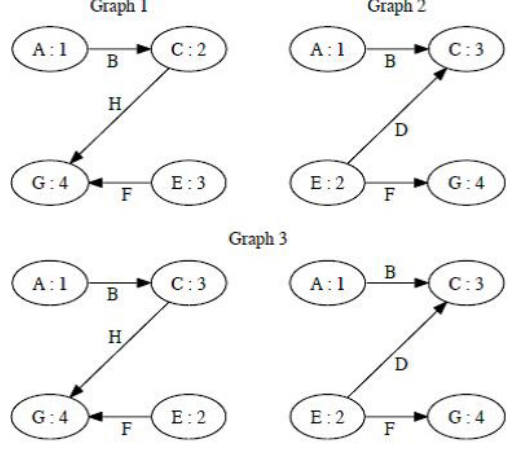
Fig. 23 Triple-edge subgraphs that meet support. Table 6 MRFSM [25] performance on biological datasets using a support of 50% and clusters of size 2 and 4 (in seconds).